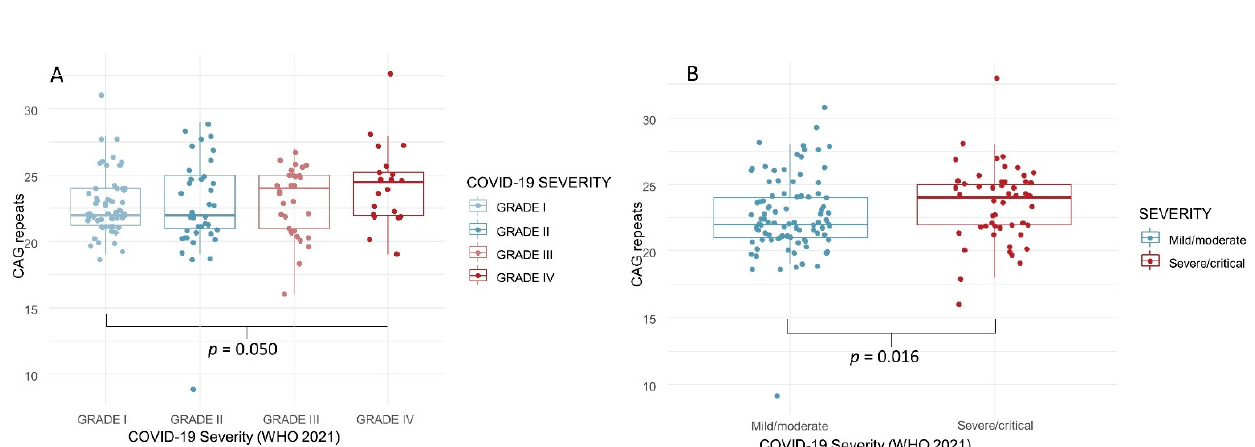
Figure 4. Percentages of subjects with ≤ 23 or >23 CAG repeats, according to disease severity (4 grades). Table 2. Results of logistic regression between COVID-19 severity (dependent variable) and the number of CAG repeats (independent variable). * Grade IV is considered as a reference. Key: OR: Odds Ratio, CI = confidence interval. OR